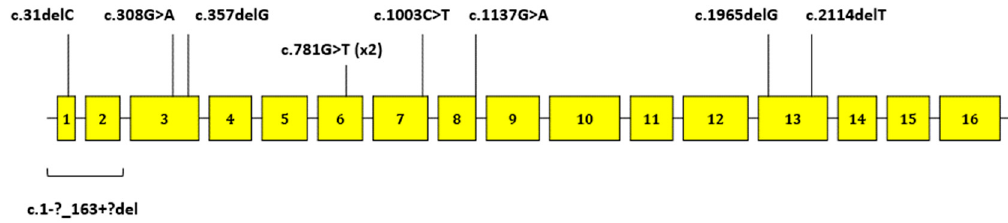
Figure 1. Schematicrepresentationofthe CDH1 geneandlocalizationoftheninepathogenic / likely-pathogenic variants identified in this work. Figure 1. Schematic representation of the CDH1 gene and localization of the nine pathogenic/likely- pathogenic variants identified in this work.